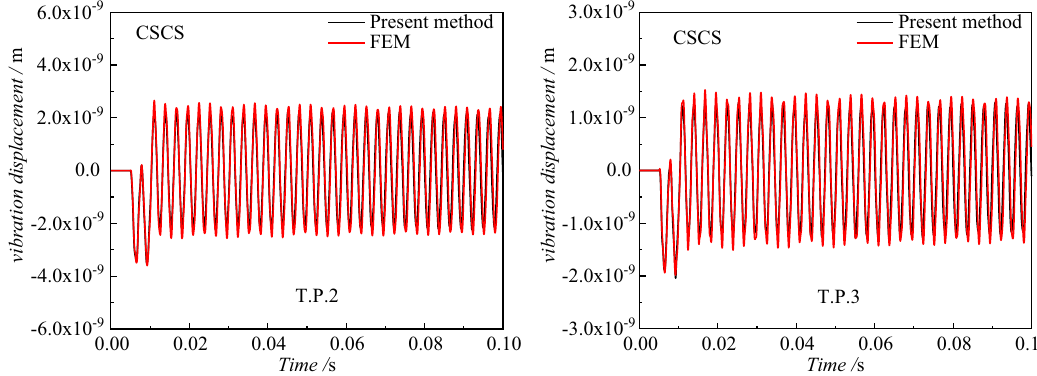
Figure 14: Comparison of the undamped transient vibration response of the present method and FEM.